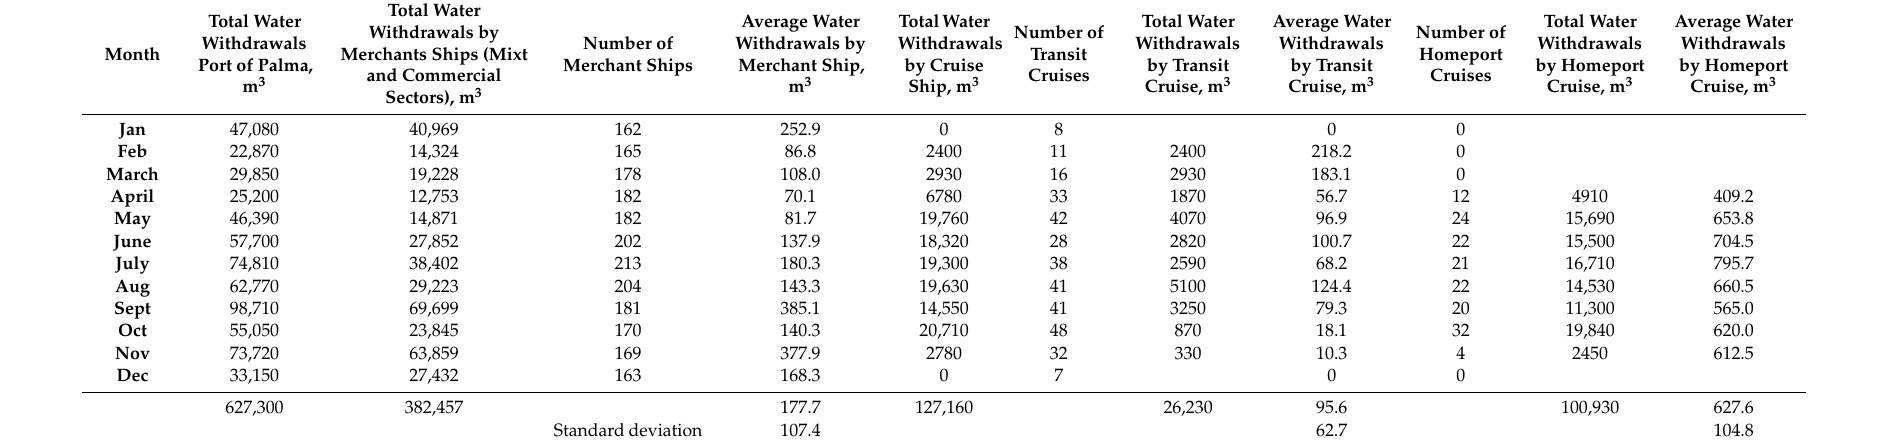
Table 1. Water withdrawals by merchants and cruise ships for the year